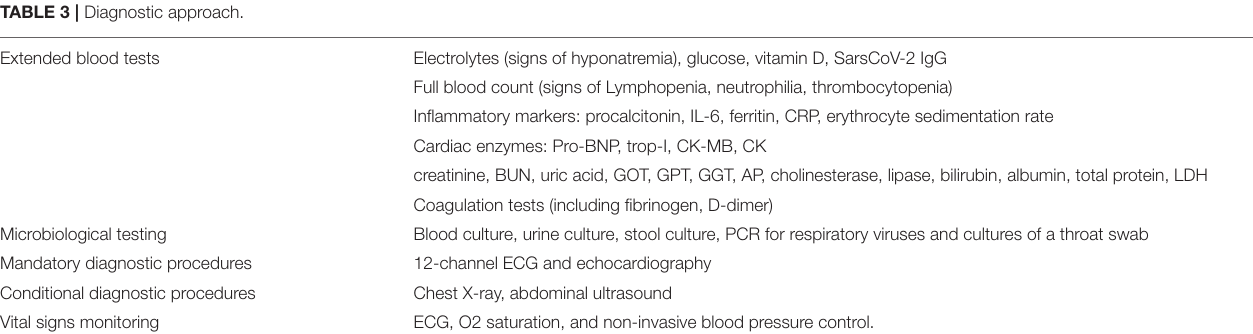
FIGURE 5 | Fibrinogen.